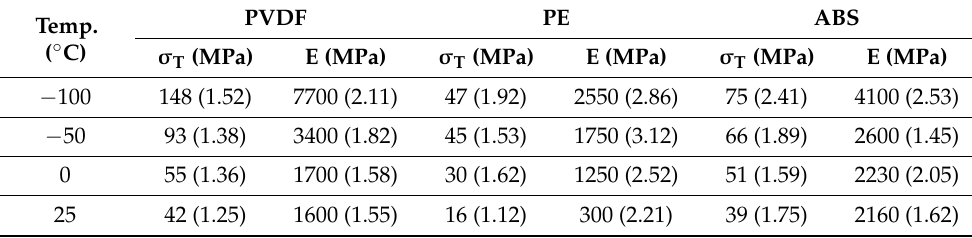
Table 2. Tensile strength and Young’s modulus from temperature-dependency tests.